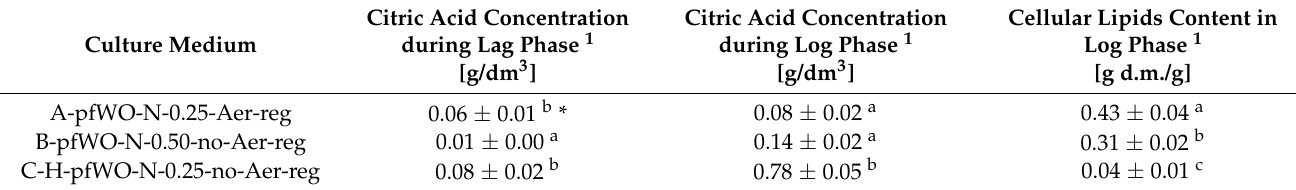
Table 2. Citric acid concentration in medium and cellular lipids content in yeast cells grown in culture media with waste post-frying oil.